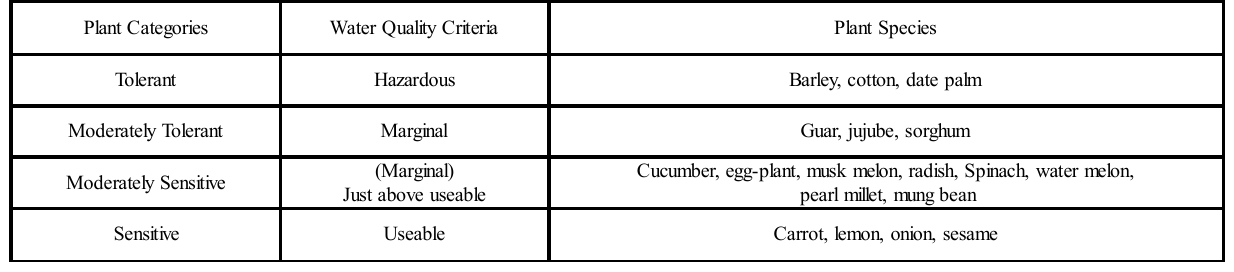
TABLE 5. SELECTED SALT-TOLERANT PLANT SPECIES GROWN UNDER DIFFERENT SALINE WATER ENVIRONMENT [14]